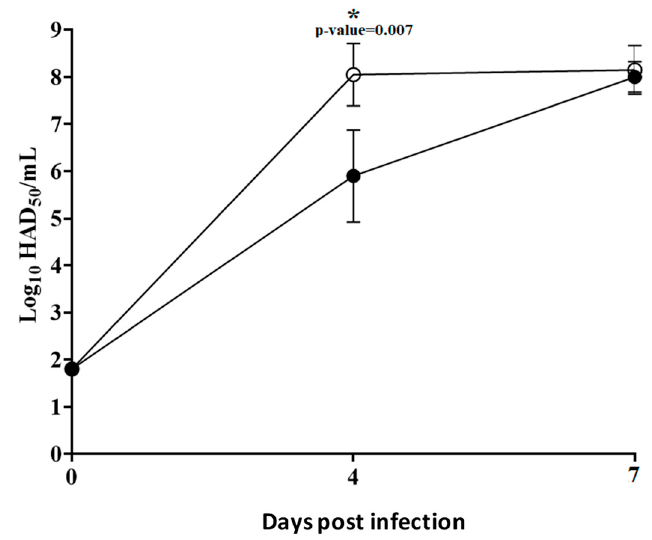
Figure 9. Viremia titers detected in pigs IM inoculated with 10 2 HAD 50 of either ASFV-G- ∆ MGF360-16R (filled symbols), or ASFV-G (empty symbols). Each curve represents the average of animal values in each of the groups. Sensitivity of virus detection: >log 10 1.8 TCID 50 /mL.